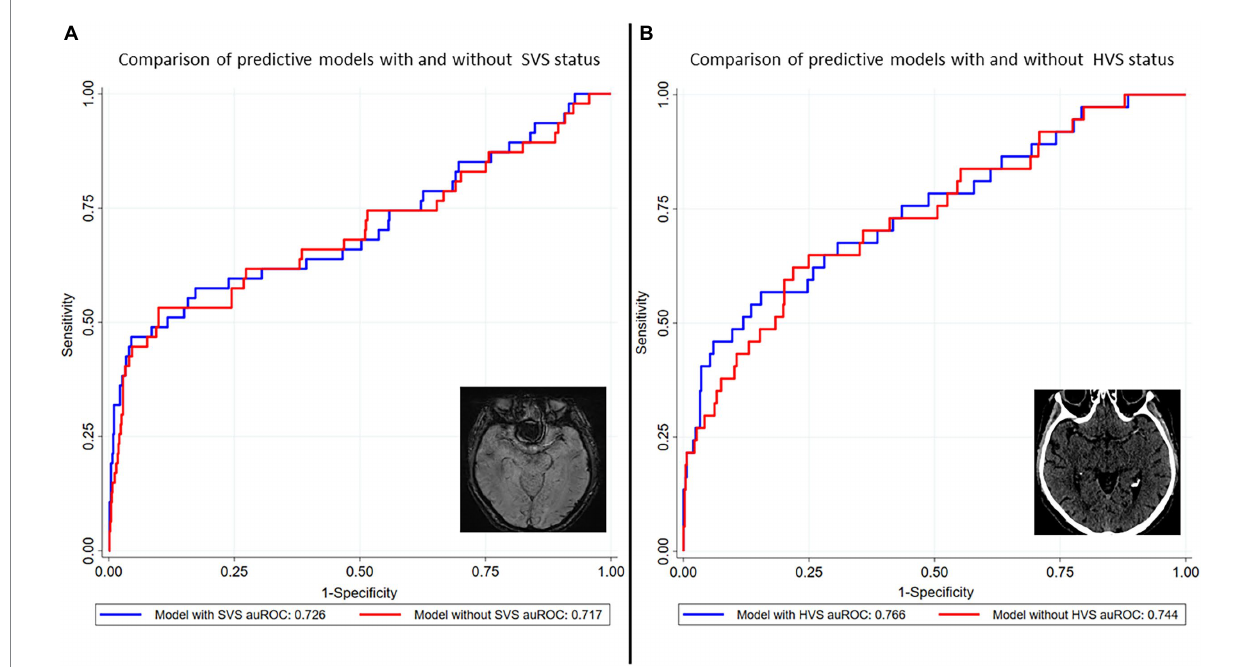
FIGURE 3 Predictive models for cancer-related stroke with and without SVS and HVS status. Models including and excluding SVS and HVS status, respectively, were developed using the covariates from logistic regression analyses (male gender, age at admission, prior treatment with anticoagulants and antiplatelet drugs, proximal occlusion, LKW-imaging, ESUS, multiterritory infarcts, CRP, D-dimer, fibrinogen, Hb and leukocytes). The auROCs of the models including and excluding SVS were 0.726 (95% CI 0.632–0.820) and 0.717 (95% CI 0.619–0.815), respectively (A) . According to the DeLong test, both models showed no significant difference ( p = 0.73). The auROCs of the models including and excluding HVS were 0.766 (95% CI 0.672–0.860) and 0.744 (95% CI 0.650–0.838), respectively (B) . The DeLong test did not show a significant difference between both models ( p = 0.41). auROC indicates area under the receiver operating characteristics curve; CRP, C-reactive protein; ESUS, embolic stroke of undetermined source; Hb, hemoglobin; HVS, hyperdense vessel sign; LKW-imaging, time between last-known-well to imaging; SVS, susceptibility vessel